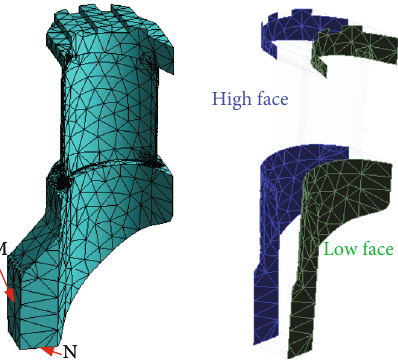
Figure 15: Grids of the turbine blade model and cyclic symmetric mesh for analysis.